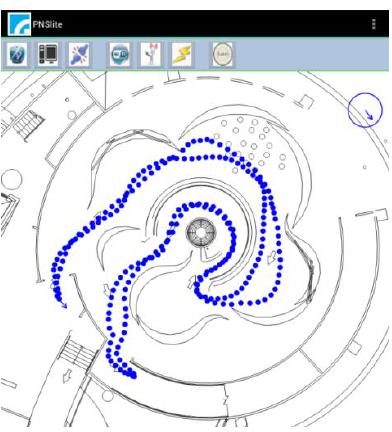
Figure 13. Demonstration of the proposed